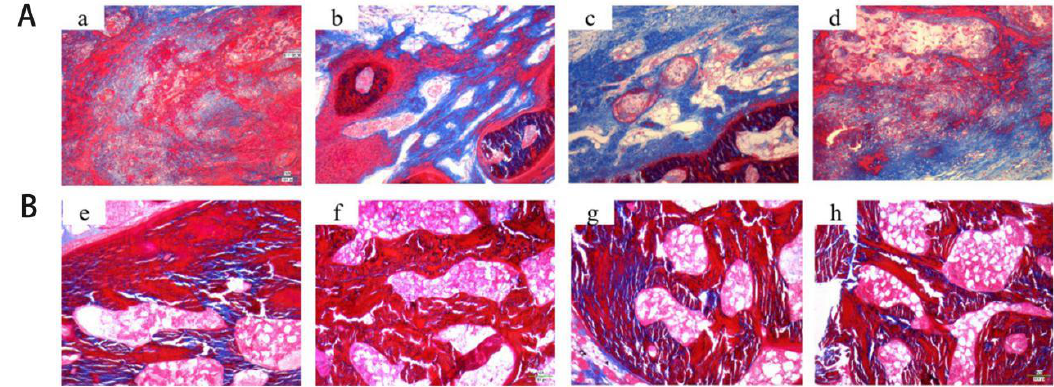
Figure 9. Masson stain (100 × ): ( A ) 4 weeks after surgery; ( B ) 8 weeks after surgery; ( a , e ) Gel / Alg group; ( b , f ) 200 µ M AgNP–Gel / Alg group; ( c , g ) 400 µ M AgNP–Gel / Alg group; ( d , h ) 600 µ M AgNP–Gel / Alg group.